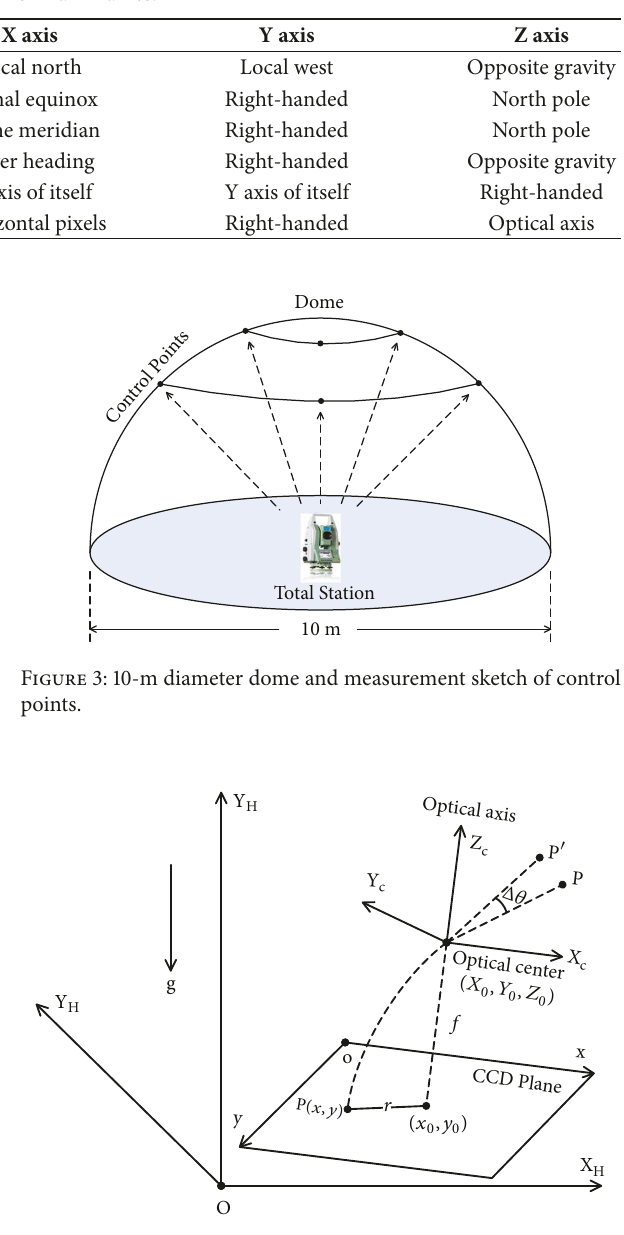
Figure 4: Geometric or physical meaning of the 12 sun sensor